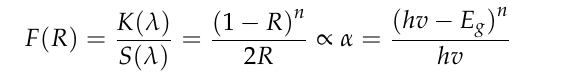
Table 3. Data on structural and physical parameters of un-doped and Cr-doped MoO 3 microrods.